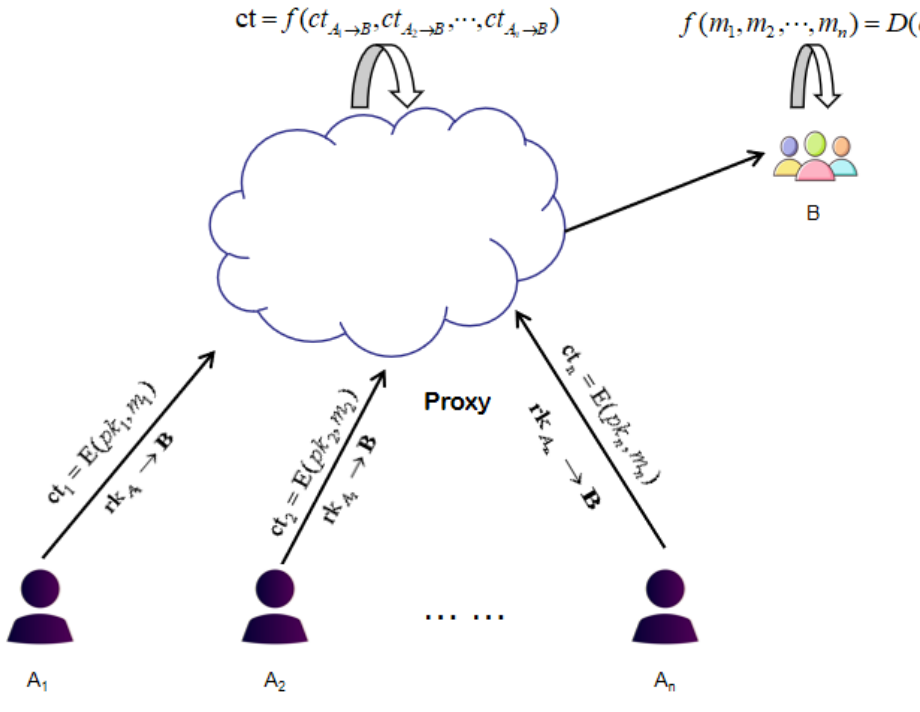
Figure 1. The homomorphic proxy re-encryption